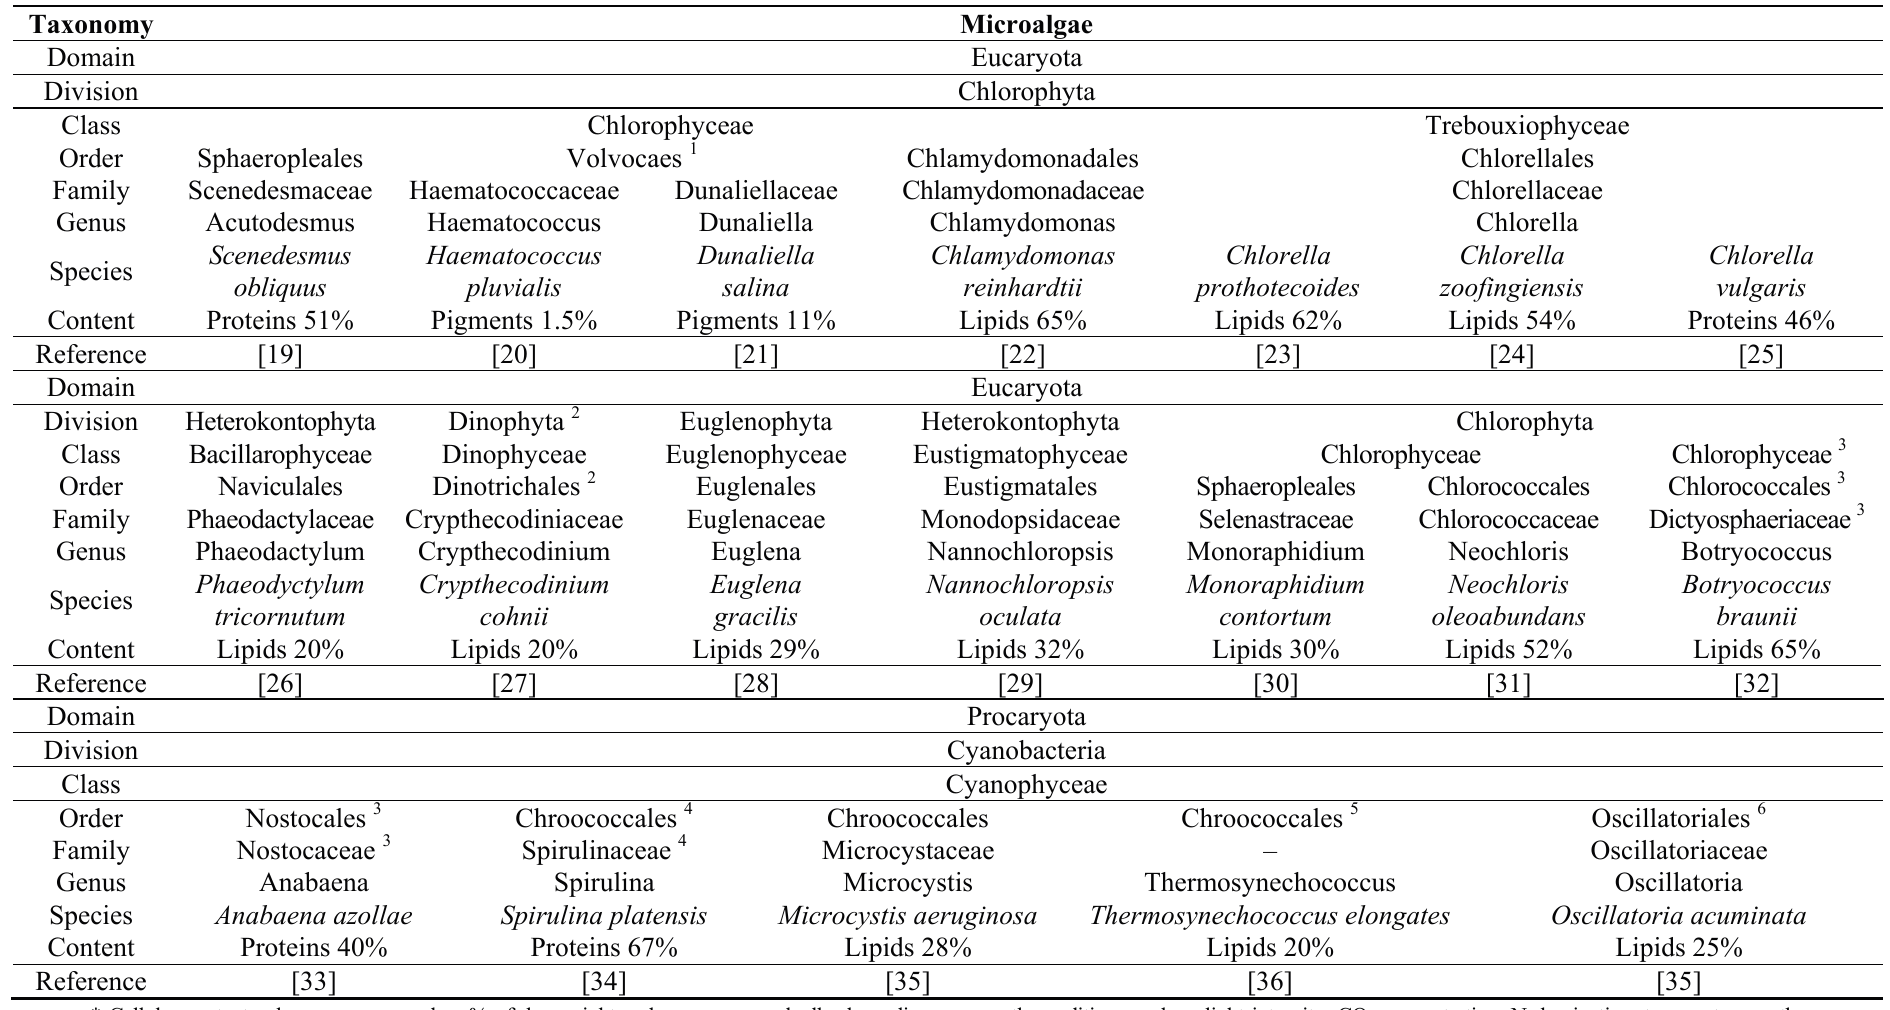
Table 1. Taxonomy classification of microalgae with cellular component content